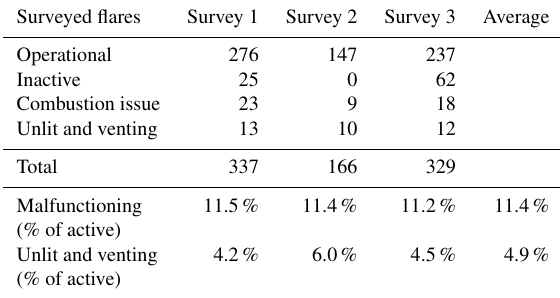
Table B1. The operational performance of Permian Basin flares as observed during three helicopter-based infrared optical gas imaging